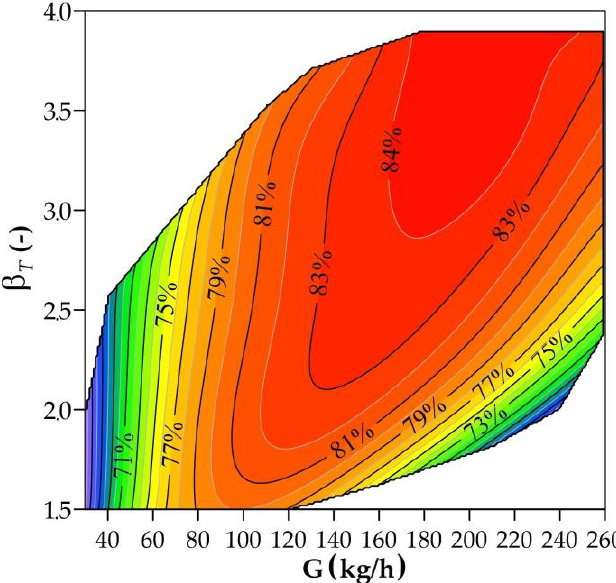
Figure 9. Optimal values of both turbine speed of rotation ( a ) and related nozzle blade angle ( b ) as a function of mass flow rate G and pressure ratio β T .